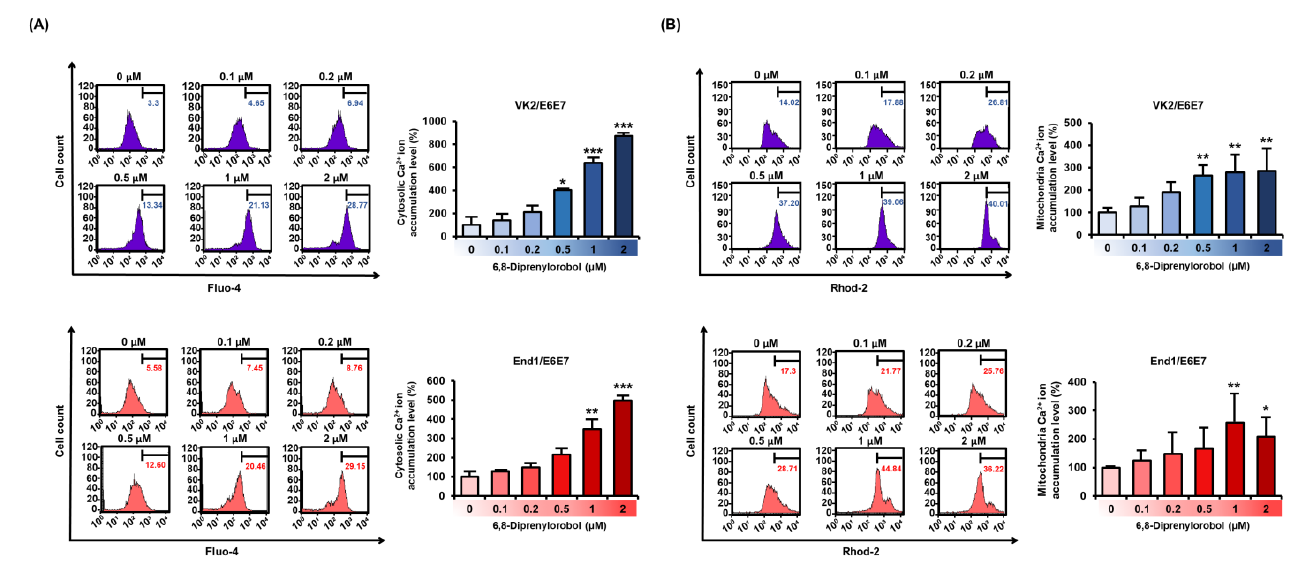
Figure 3. Effects of 6,8-diprenylorobol on disrupting calcium homeostasis in VK2/E6E7 and End1/E6E7. ( A ) FACS analysis of cytosolic calcium ion accumulation in VK2/E6E7 and End1/E6E7 cells stained with fluo-4 AM dye. ( B ) The accumulation of mitochondrial calcium in VK2/E6E7 and End1/E6E7 cells was measured by staining with rhod-2 AM. The right part of the histogram’s peak was measured, and its values were converted to a bar graph based on a percentage-ratio. Asterisks indicate significant levels between vehicle-treated cells and 6,8-diprenylorobol-treated cells (* p < 0.05, ** p < 0.01, and *** p < 0.001).